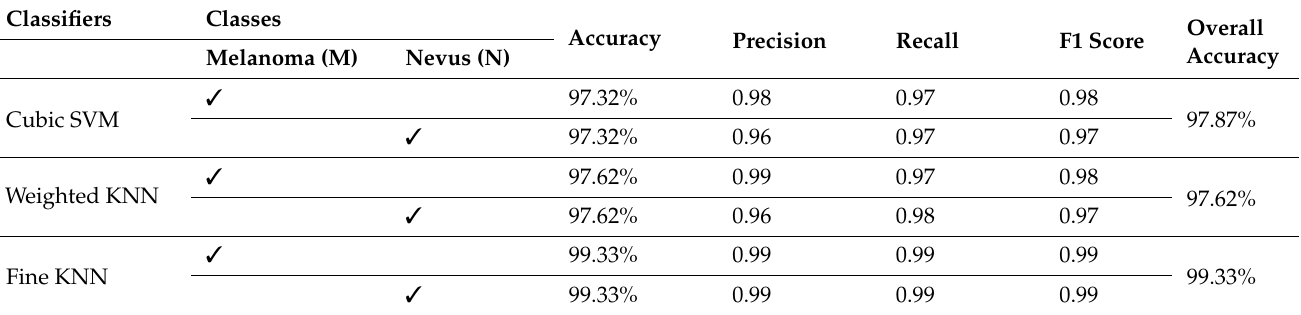
Table 12. Comparisons of proposed classification method outcomes with existing approaches.